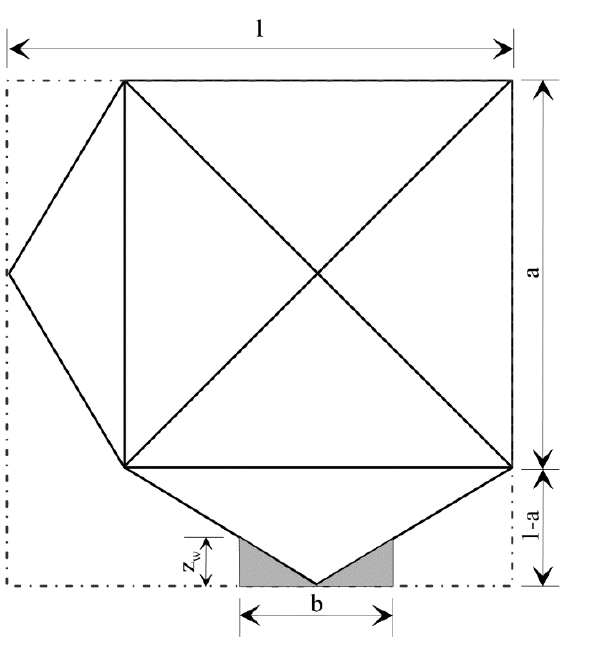
Figure 3: An idealized grain model according to Gemant (Farouki,